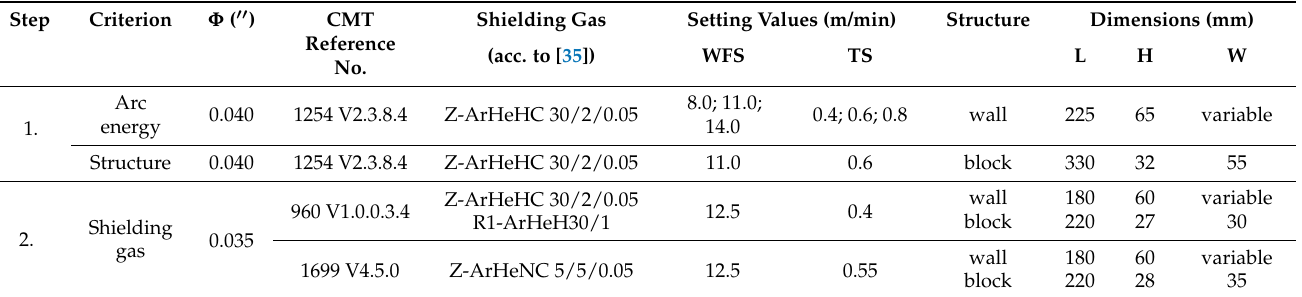
Table 2. Experimental program for generation of different WAAM parts with HY282 with variable arc energy and shielding